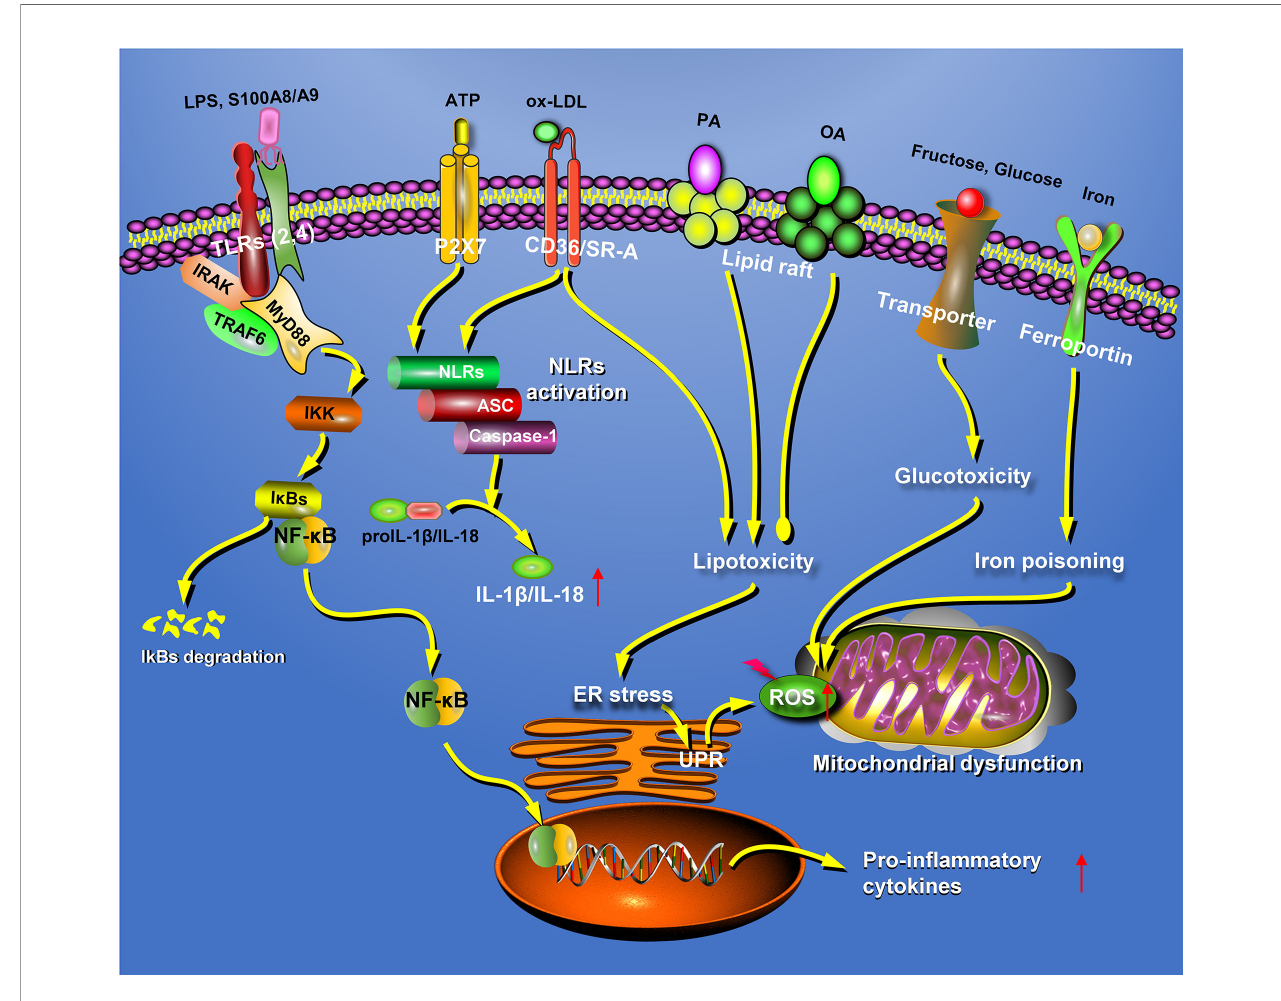
FIGURE 2 | Hepatic macrophages participate in the pathogenesis of fatty liver disease in many different patterns. In fatty liver disease, the macrophages can recognize extracellular stimuli through pattern recognition receptors, including TLRs and NLRs, resulting in the secretion of in fl ammatory factors. In addition, macrophages could also participate in the progression of NAFLD through lipotoxicity, glucotoxicity, and iron poisoning. ATP, adenosine triphosphate; ER, endoplasmic reticulum; NLRs, nucleotide-binding oligomerization domain-like receptors; OA, oleic acid; PA, palmitic acid; P2X7, P2X purinoceptor 7; ROS, reactive oxygen species; S100A8, S100 calcium-binding proteins A8; SR-A, scavenger receptor-A; TLRs, Toll-like receptors; UPR, unfolded protein